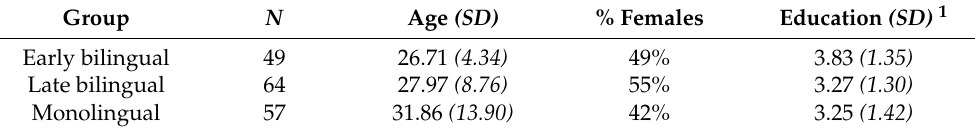
Table 1. Participant characteristics, by group, gender, and parental education.